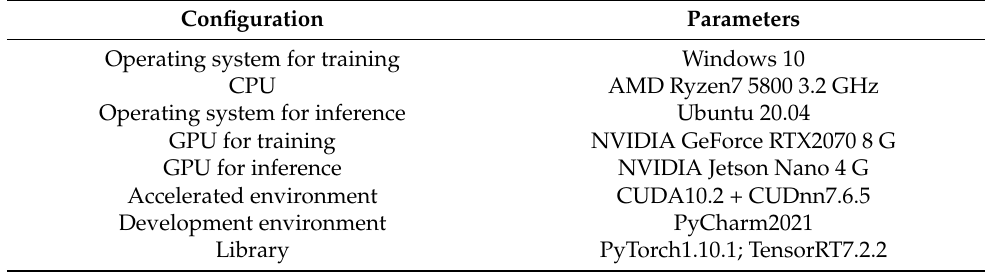
Table 2. Experimental